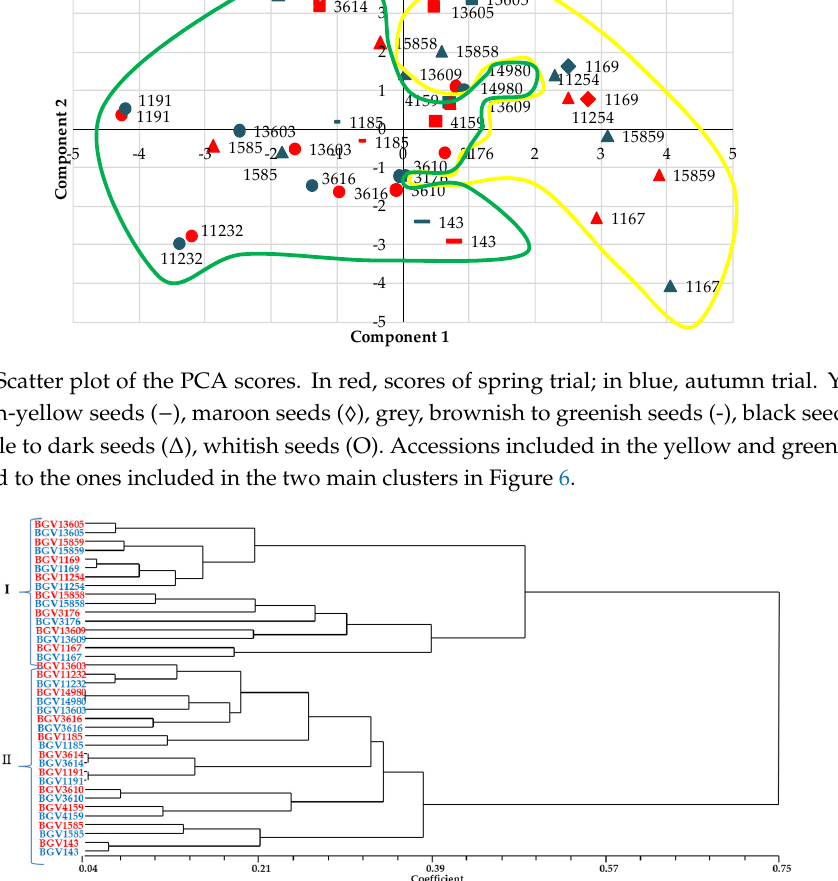
Figure 6. UPGMA (unweighted pair group method with arithmetic mean) phenogram of the 19 accessions of Phaseolus cultivated in two consecutive seasons based on 17 quantitative descriptors. Phenetic relationships were based on Euclidean pairwise distances estimates. I and II represent the two main clusters obtained. In red, scores of spring season; in blue, autumn